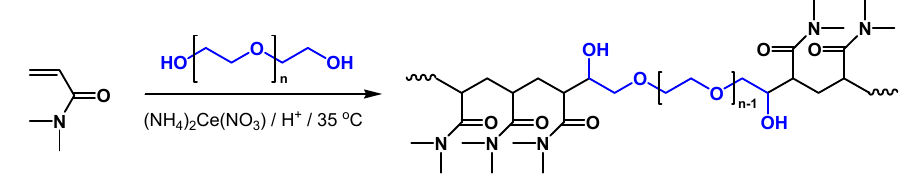
Figure 1. Reaction scheme of the synthesis of PDMA- b -PEO- b -PDMA triblock copolymer.